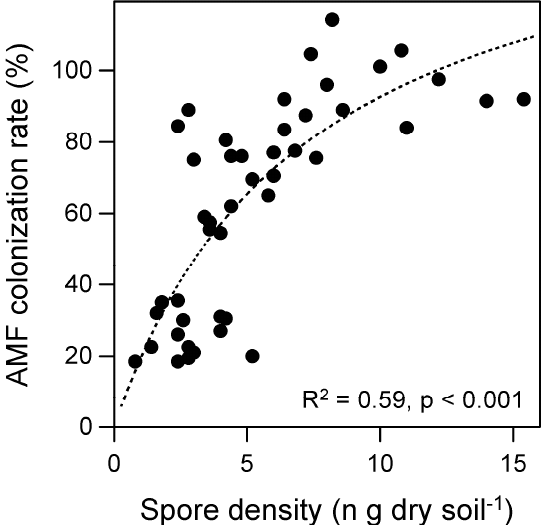
Figure 4. Correlation between AMF colonization rates (%) of Eragrostis tef roots and AMF spore densities (n per g dry soil − 1 ) across three treatments (i.e., cropland soil, cropland soil inoculated with forest soil and after N-P fertilisation). Colonization rates >100% are caused by overlapping of different morphological structures (see Materials and Methods).